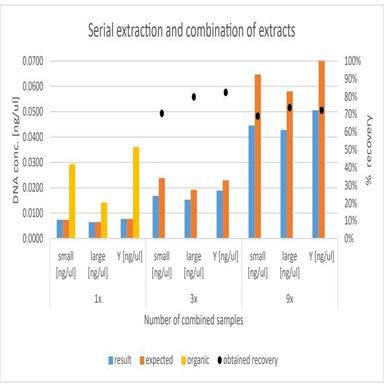
Comparison of DNA qPCR results for a single sample of DNA extracted using the EZ2 Connect instrument and the organic method with results of serial extraction together with the 3x and 9x extract combination. The expected DNA concentration values are marked on the graph, resulting from the multiple-cumulative measurement result obtained for a single extraction, quantification results, and the obtained recovery as the measured sample DNA concentration divided by the expected concentration expressed as a percen